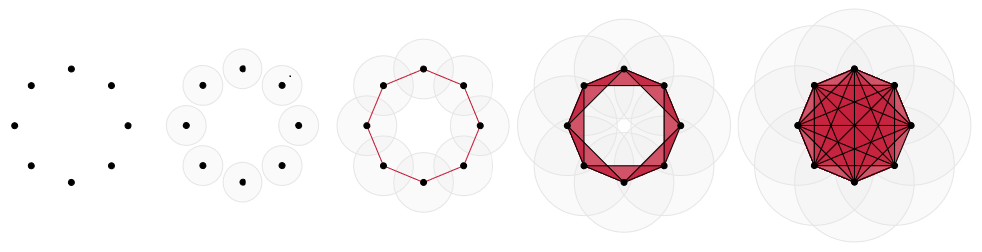
Figure 5. (Vietoris–Rips) filtration of points sampled from a circle. Images from [12].